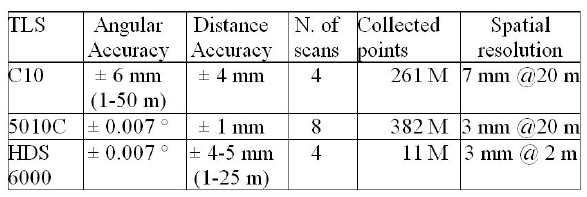
Table 2. Laser scanners technical data